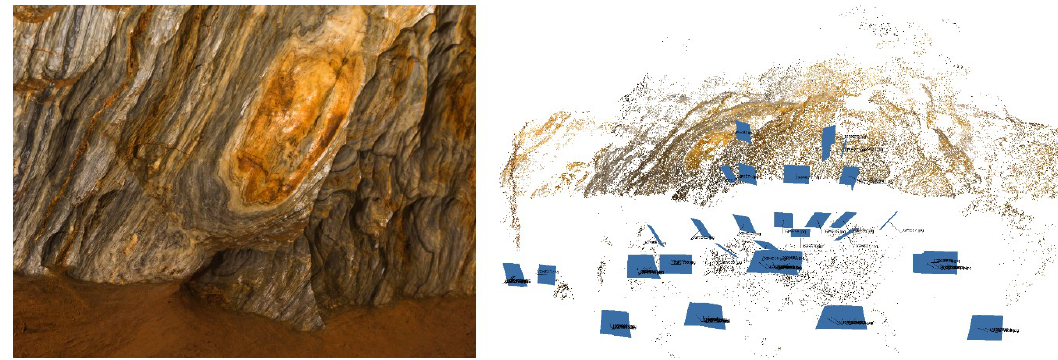
Figure 11. Left—detail of the imaged surface; right—overview of imaging stations.